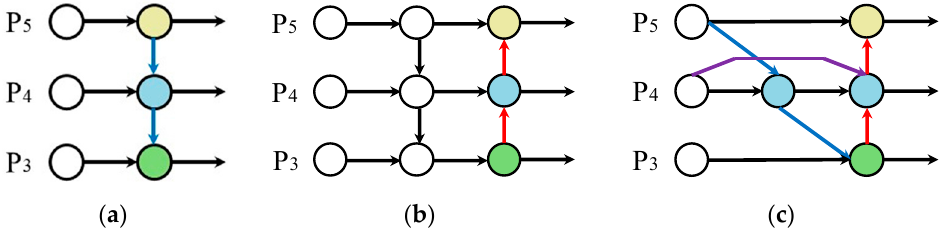
Figure 2. Feature network structure. ( a ) The top-down channel provided by the FPN enables for the fusion of multi-scale features from layers 3 to 5(P3–P5); ( b ) On top of the FPN, the PAN establishes a second bottom-up channel; and ( c ) The BiFPN network with weighted feature fusion and repeated bidirectional cross-scale connections.